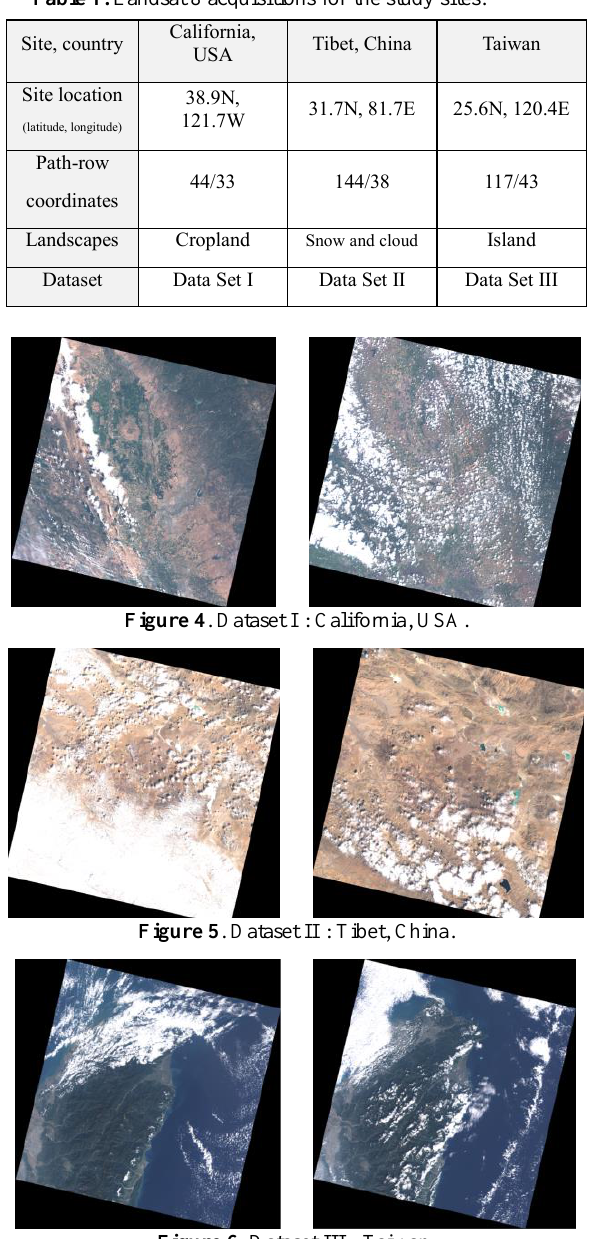
Figure 6 . Dataset III :